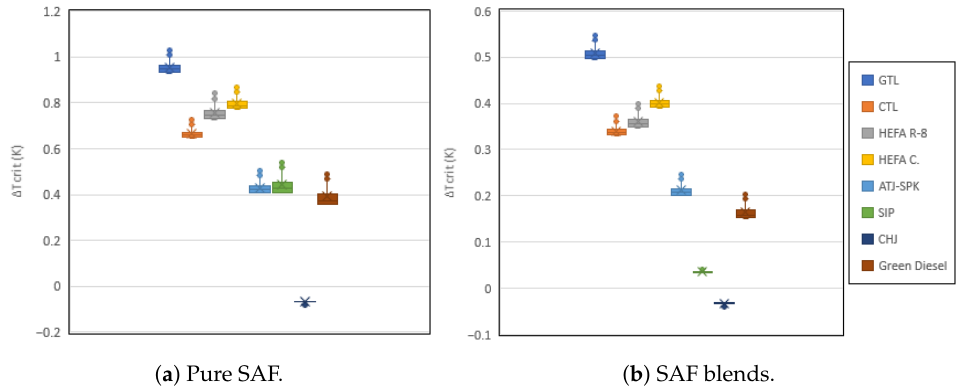
Figure 7. Absolute differences in threshold